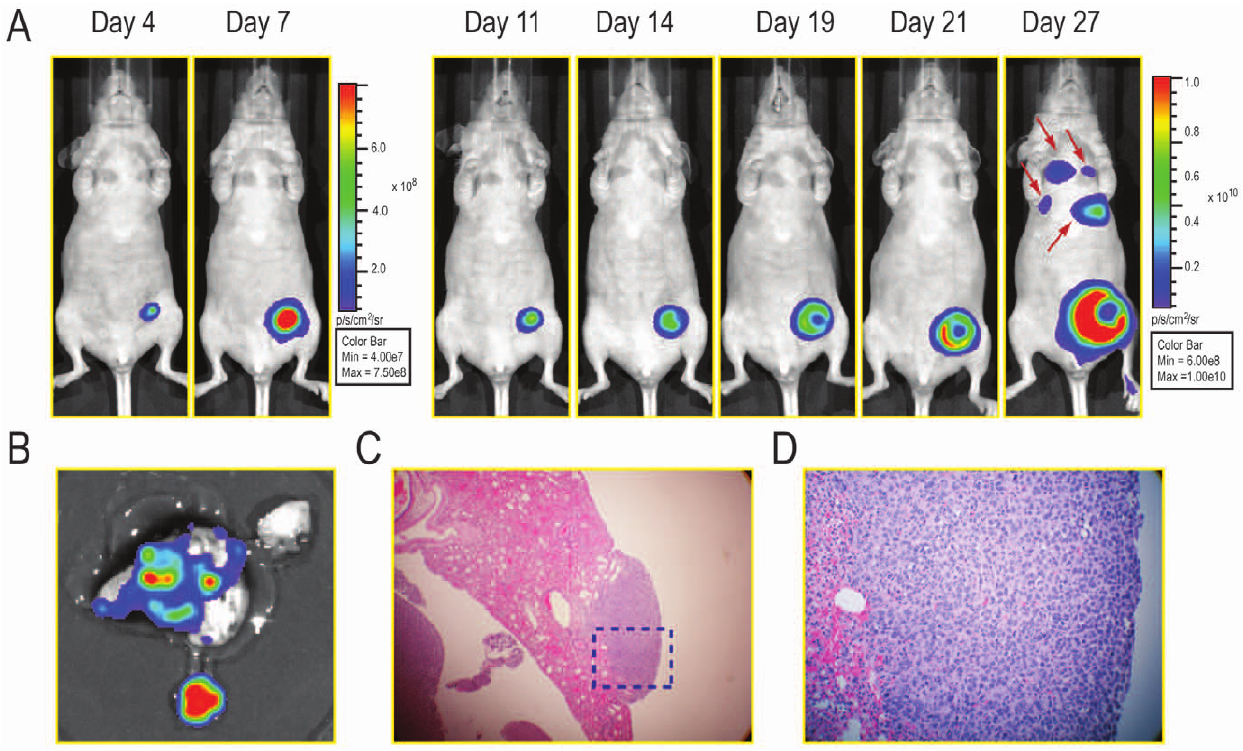
Figure 4. Non invasive detection of micrometastases and histological analysis. (A) Female nu/nu mice were inoculated with 5 6 10 5 4T1- luc2-1A4 cells orthotopically into the abdominal mammary fat pads[1]. Bioluminescent images were taken longitudinally. At post-implantation day 27, micrometastases were detected in lungs (arrows) (B) The lungs were isolated at post-implantation day 27 and ex vivo image was taken. (C,D) Lung tissues were fixed in formalin and embedded in paraffin. H&E staining was performed and analyzed. Panel D represents the dotted area in panel